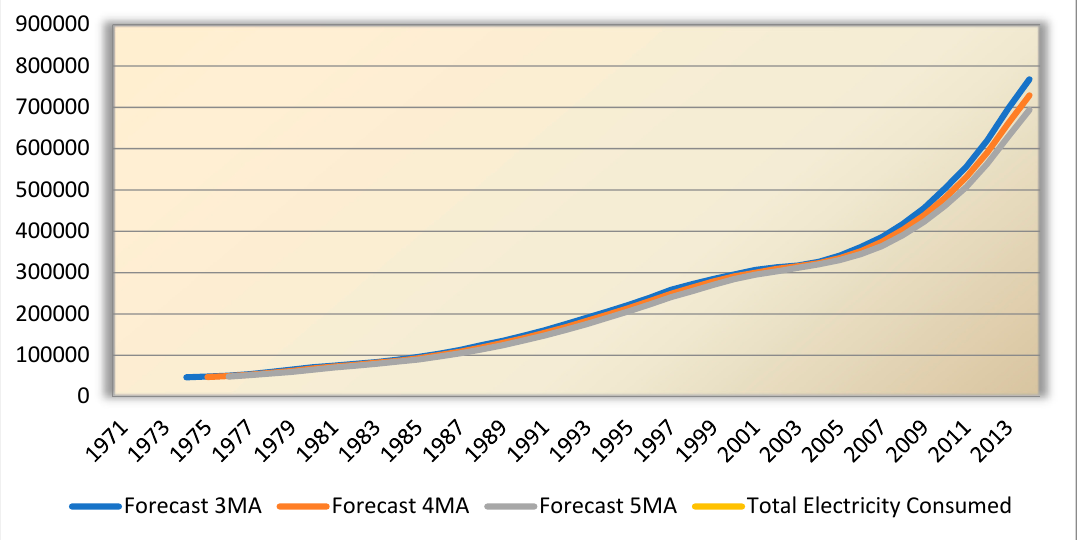
Figure 10. Chart for Weighted moving average method (1971–2015).